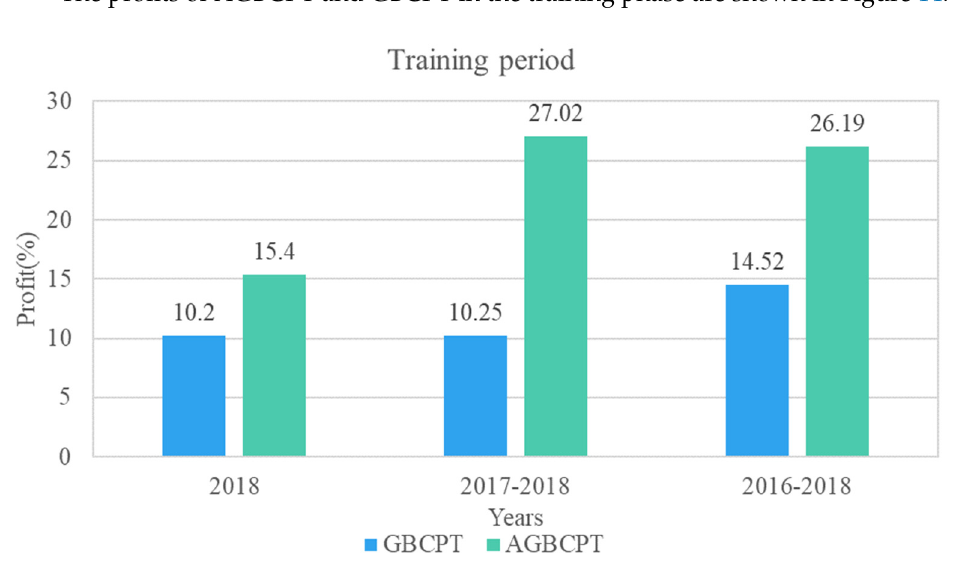
Figure 14. AGBCPT and GBCPT profits in training phase.